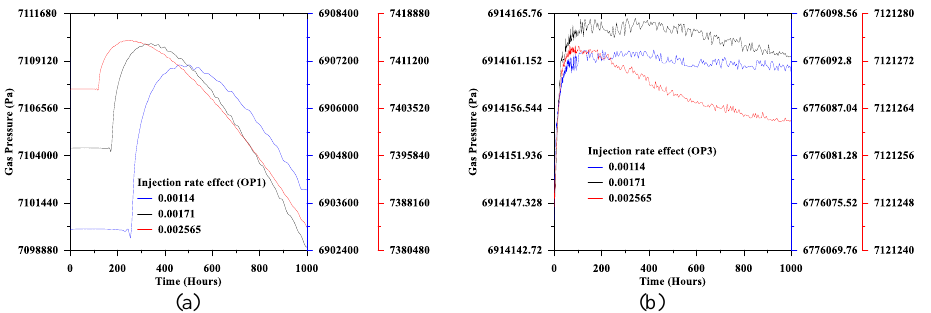
Figure 19. Injection rate effect on the gas pressure: ( a ) OP1 and ( b ) OP3.